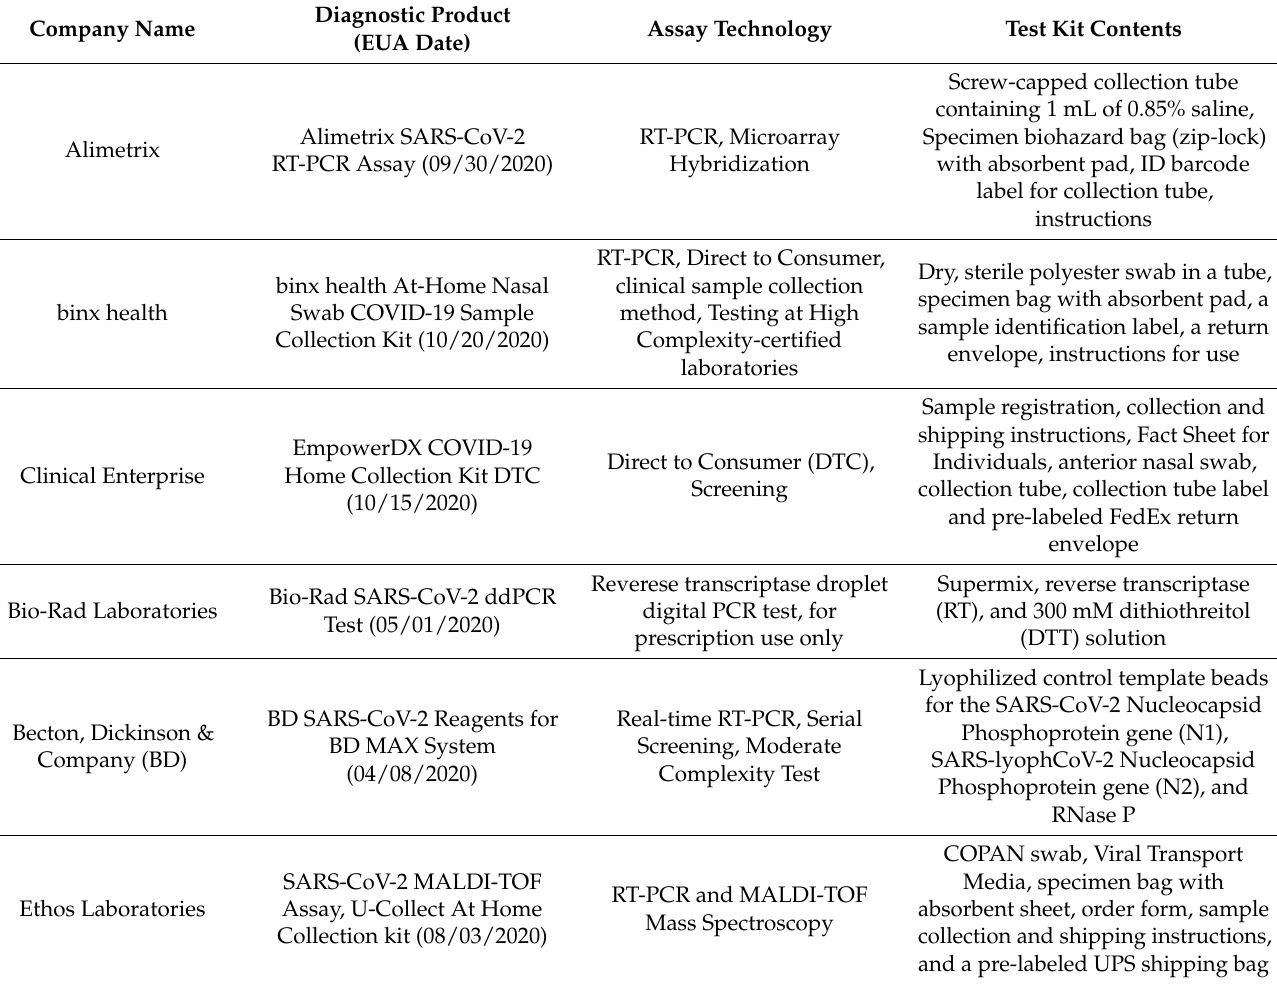
Figure 2. Steps for the reverse transcriptase PCR (RT-PCR) COVID-19 testing. ( a ) The sample is collected and put in a transport medium. ( b ) The virus is inactivated by detergents or by heating. ( c ) Viral RNA is extracted. ( d , e ) The contents are transferred to a 96 well plate for cDNA synthesis and detection by RT-qPCR or sample barcoding and high-throughput DNA sequencing. ( f , g ) In alternate method, the RNA extraction step can be omitted through direct inactivation of the virus by heating or direct lysis by detergents. The figure is reproduced and adapted under the Creative Commons license from Ioanna Smyrlaki et al., Nature Communications, Springer Nature (2020) [19]. Table 1. At-Home Molecular Diagnostic (RT-PCR) Tests using Respiratory Specimens and granted FDA Emergency Use